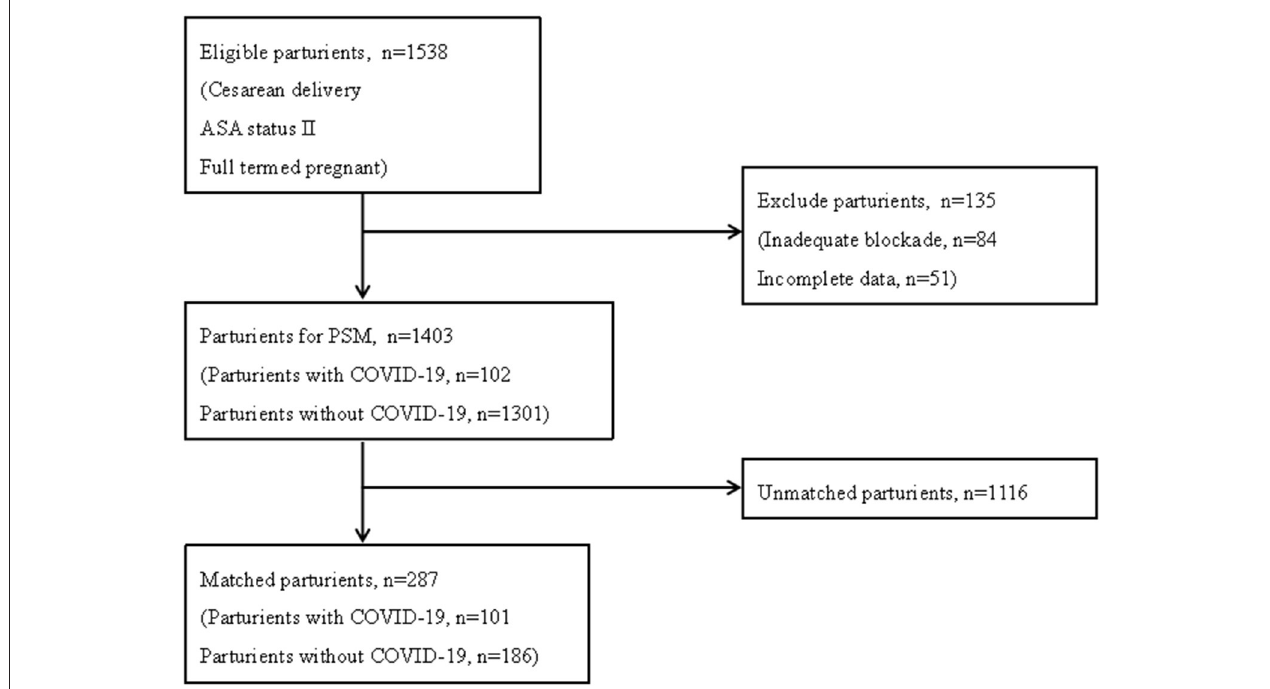
FIGURE 1 | The study